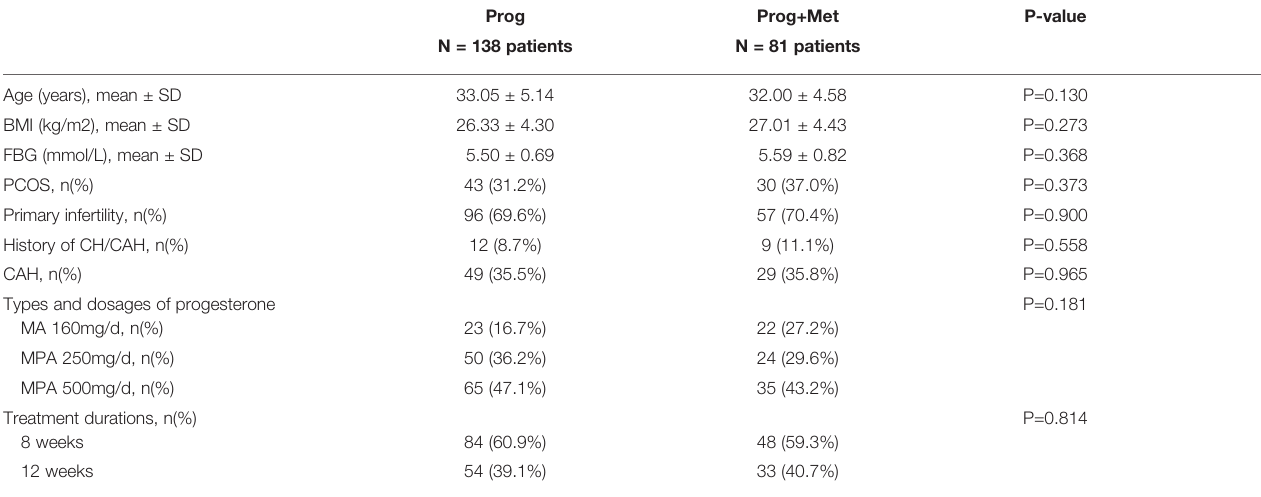
TABLE 1 | Baseline characteristics of the patient.